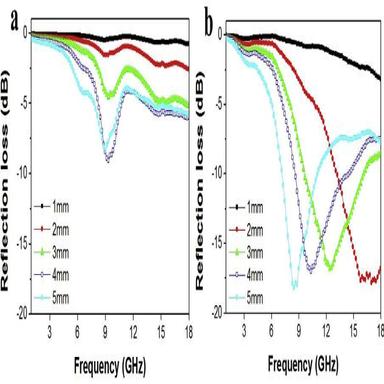
The calculated RL of the bulk NiFe2O4 (a) and PF-NiFe2O4 (b).